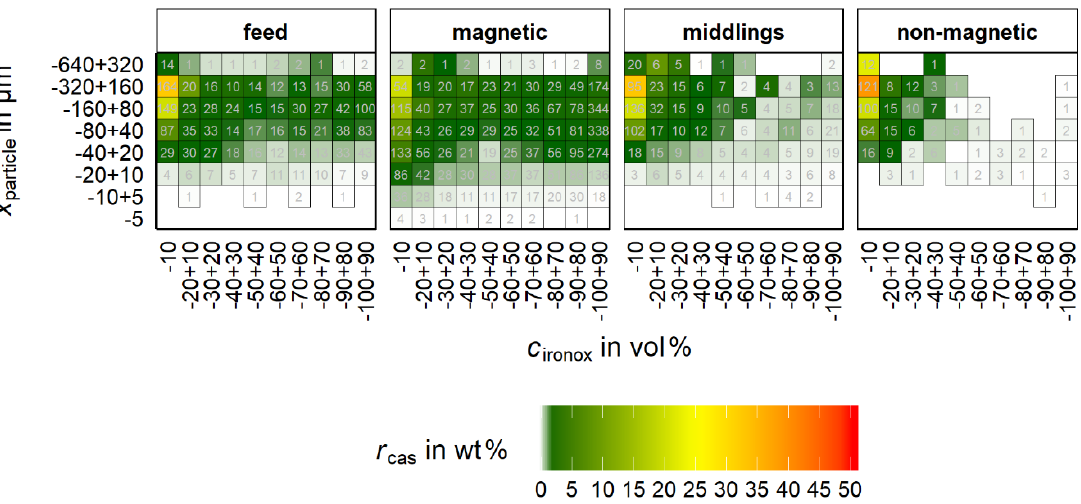
Figure 13. Distribution of cassiterite ( r cas ) as function of x particle and c ironox in the feed and the products (recovery in each product sums up to 100%; green: 1%, yellow: 25%, red: 50%). The numbers in the boxes indicate the amount of particles in each bin.